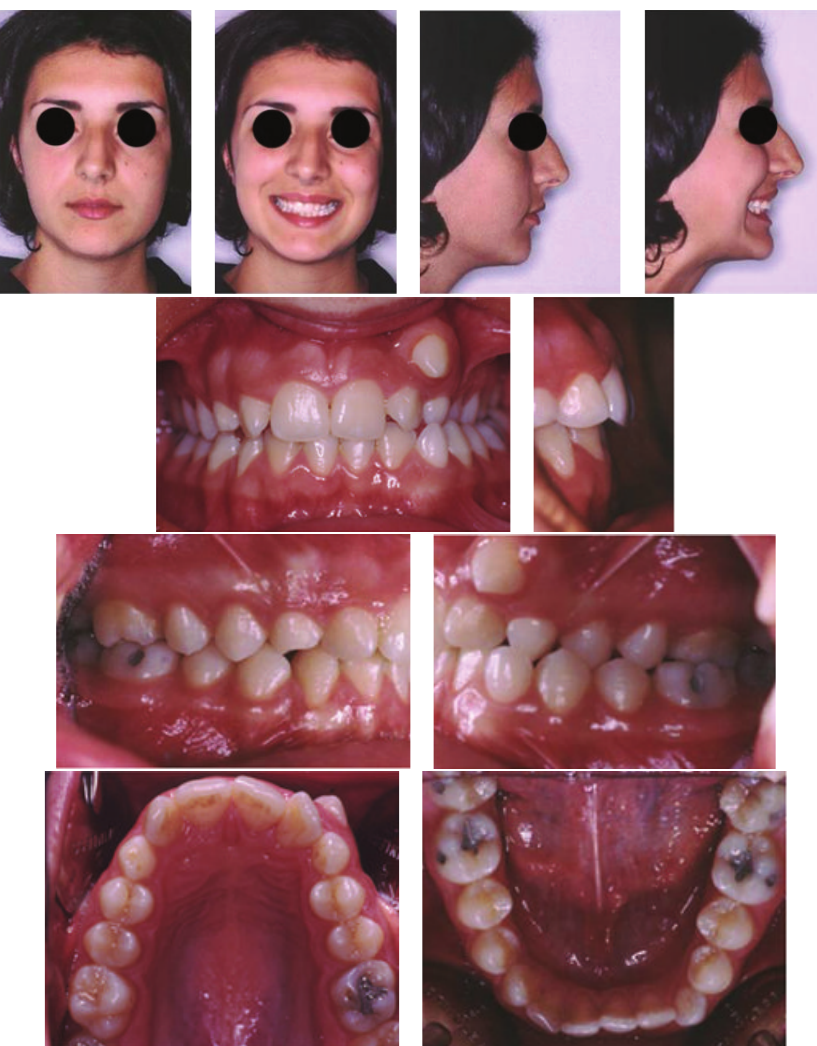
Figure 1: Extraoral and intraoral photographs before